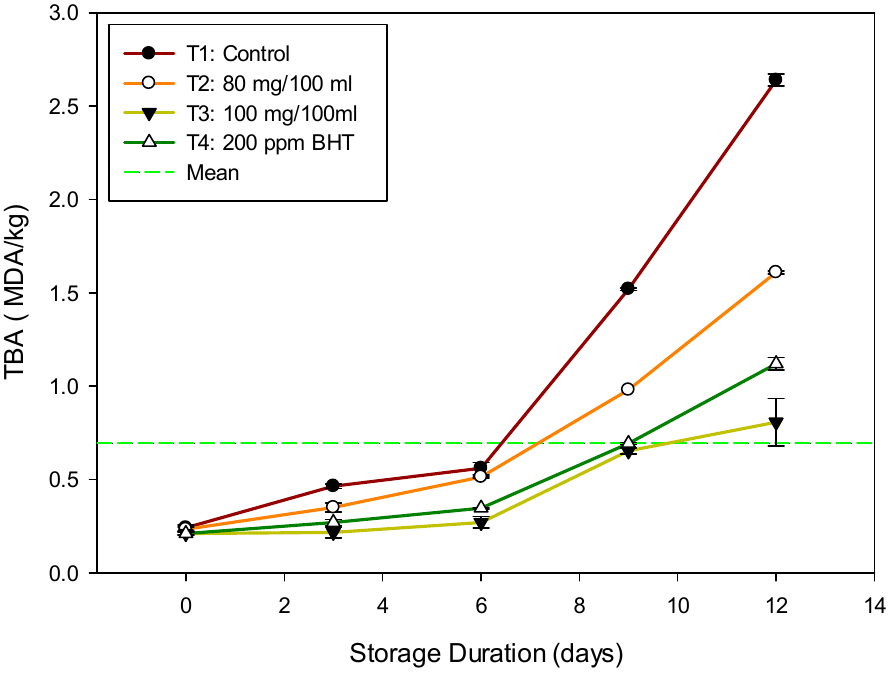
Figure 3. Mean TBA value, with standard deviation bars of Nile Talipia fillets during storage for 12 days at 5 °C.